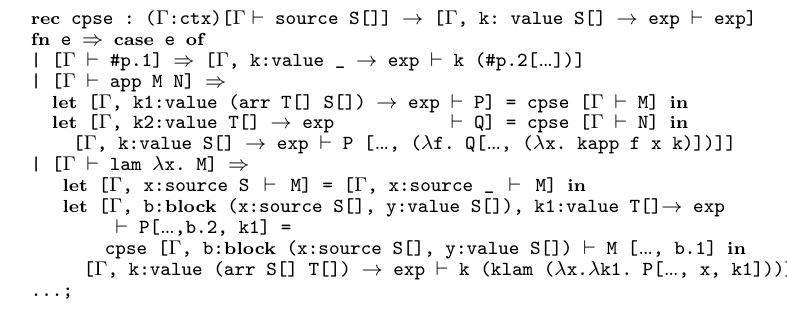
Fig. 7. Implementation of CPS in